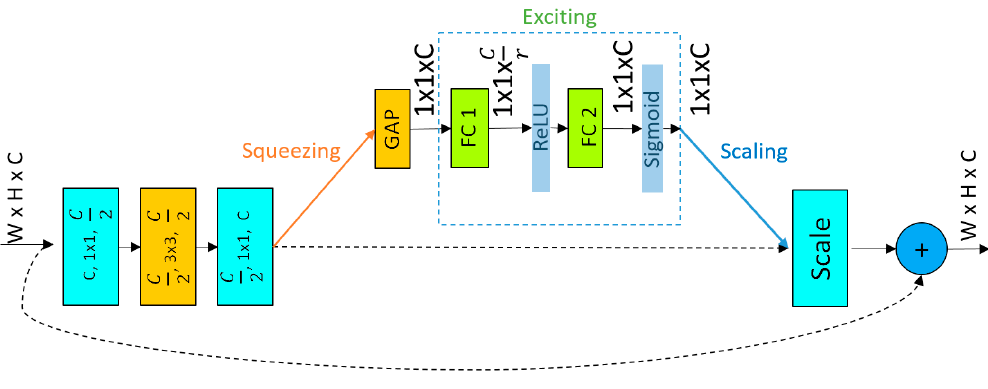
Figure 2. Inside SE-Block. In first three convolutional blocks, first value represents the number of input feature maps, the second value represents the kernel size, and the third value represents the number of output channels. The dashed arrows represent the identity mapping. GAP, FC1, FC2 and r represent global average pooling, two densely connected layers and reduction ratio respectively.